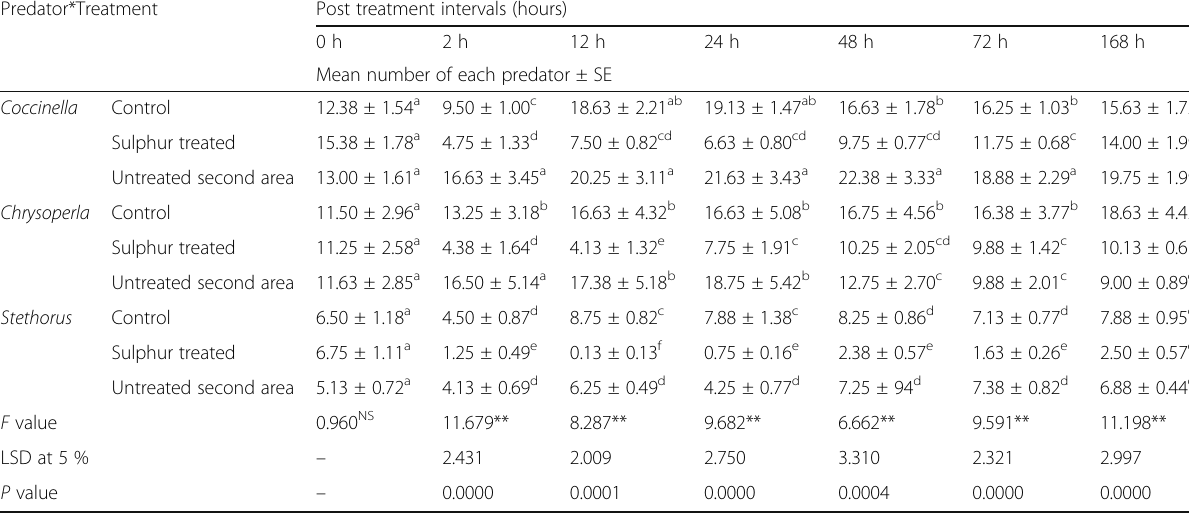
Table 4 Interaction two factors (Predator*Treatment) with respect to the adult predators ’ abundance Predator*Treatment Post treatment intervals